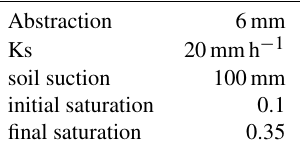
Table 3. Parameters used in the G–A